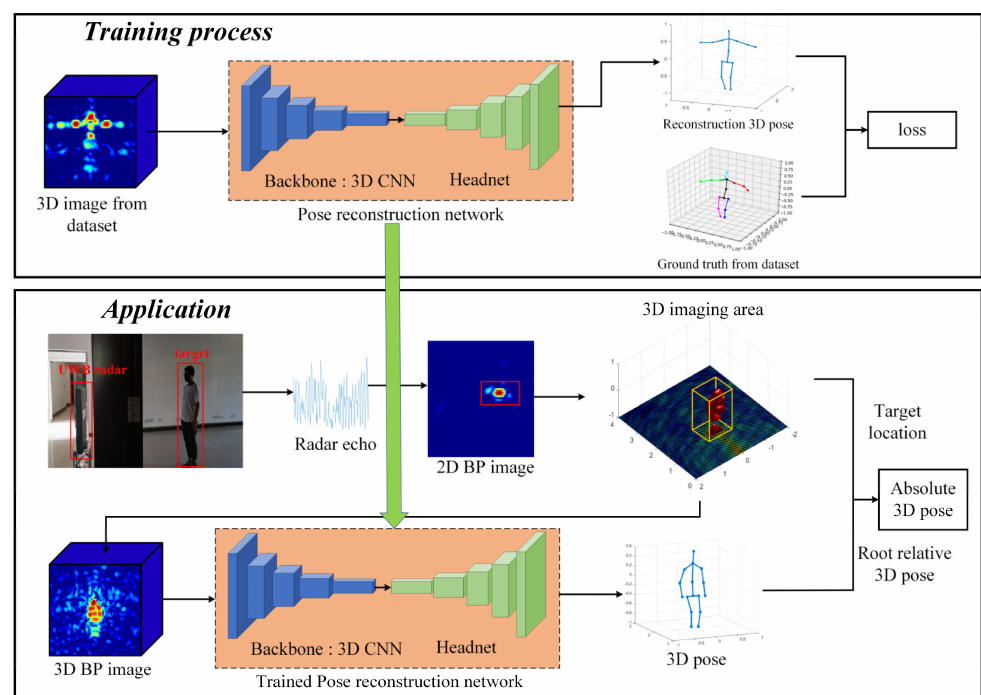
Figure 3. The whole flowchart of our proposed pose reconstruction